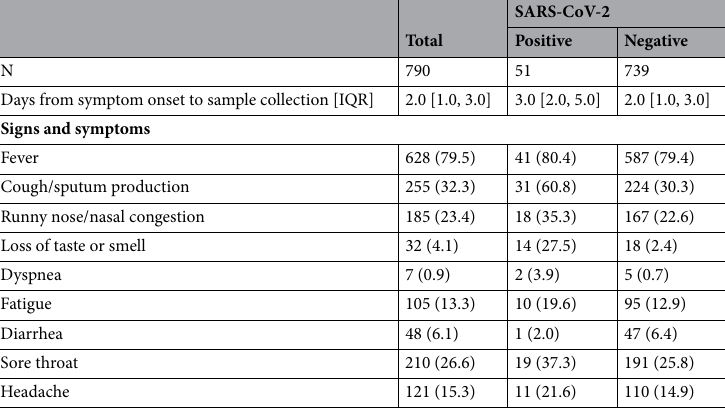
Table 2. Characteristics of symptomatic participants and cases infected with SARS-CoV-2. IQR interquartile